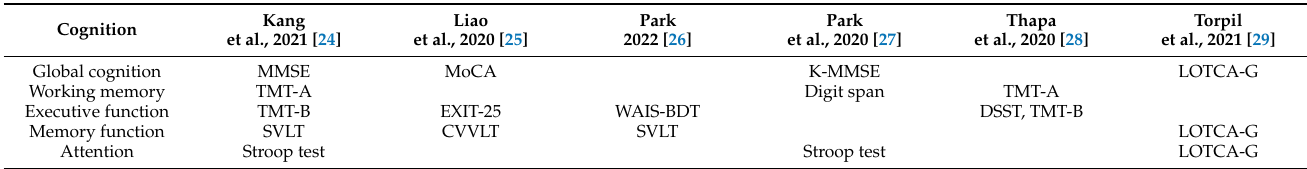
Table 1. Classification of cognitive function.